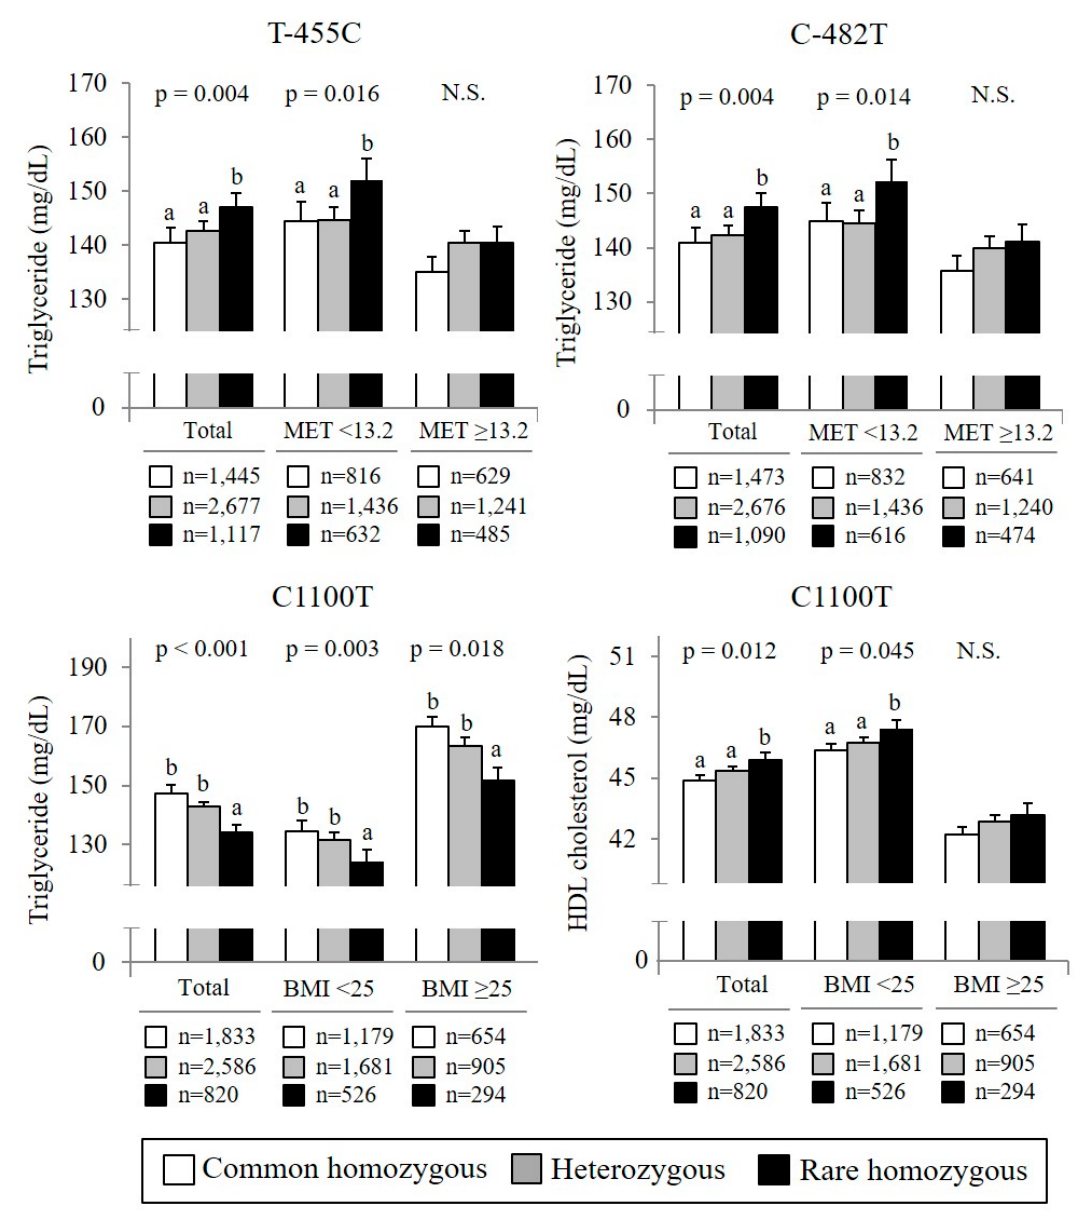
Figure 2. Association of APOC3 genotype with triglyceride and HDL cholesterol by stratification for physical activity or BMI level. BMI, body mass index; HDL cholesterol, high-density-lipoprotein cholesterol; N.S., not significant; MET, metabolic equivalent. The median level of METs in the total population is 13.2 (h/day). Significance was tested using generalized linear model with Bonferroni’s multiple comparisons after adjusting for age, gender, area, total energy intake, physical activity, education level, smoking status, alcohol use, and BMI. Some variables included missing values. Circulating triglyceride was tested after log transformation. a,b The same lower-case letter means non-significant difference among